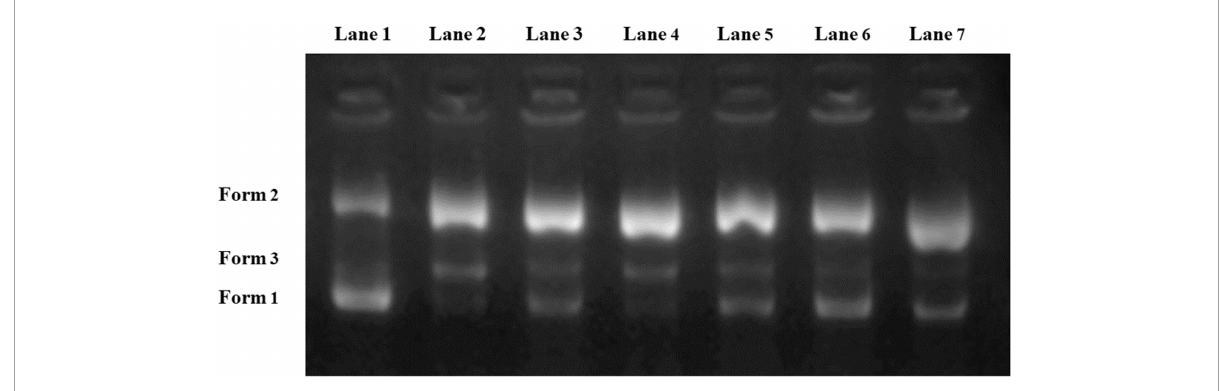
FIGURE5 Oxidative damage protective ability of Noni polysaccharide to pUC18 supercoiled plasmid DNA. Lane 1: native DNA; Lane 2: DNA + H 2 O 2 +